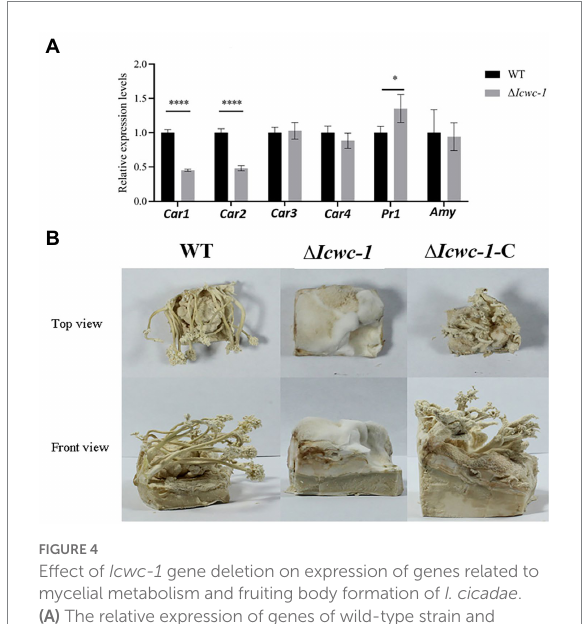
FIGURE 4 Effect of Icwc-1 gene deletion on expression of genes related to mycelial metabolism and fruiting body formation of I. cicadae . (A) The relative expression of genes of wild-type strain and Icwc-1 mutant strain in I. cicadae detected by RT-PCR. (B) Fruiting body formation of I. cicadae (WT, ∆ Icwc-1 and ∆ Icwc-1 -C). The symbol “ * ” indicates a significant difference ( p < 0.05) compared with the original strain, while “ **** ” indicates an extremely significant difference ( p < 0.01). Gene expression profile regulated by Icwc-1